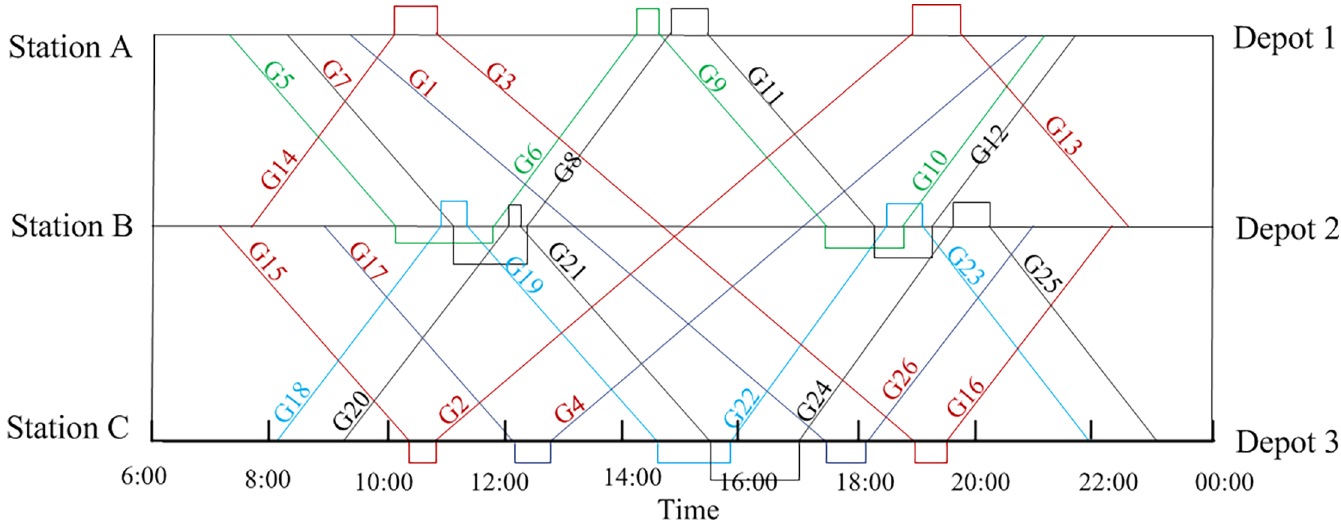
Fig 4. EMU circulation plan in the conventional mode based on the time-space diagram.